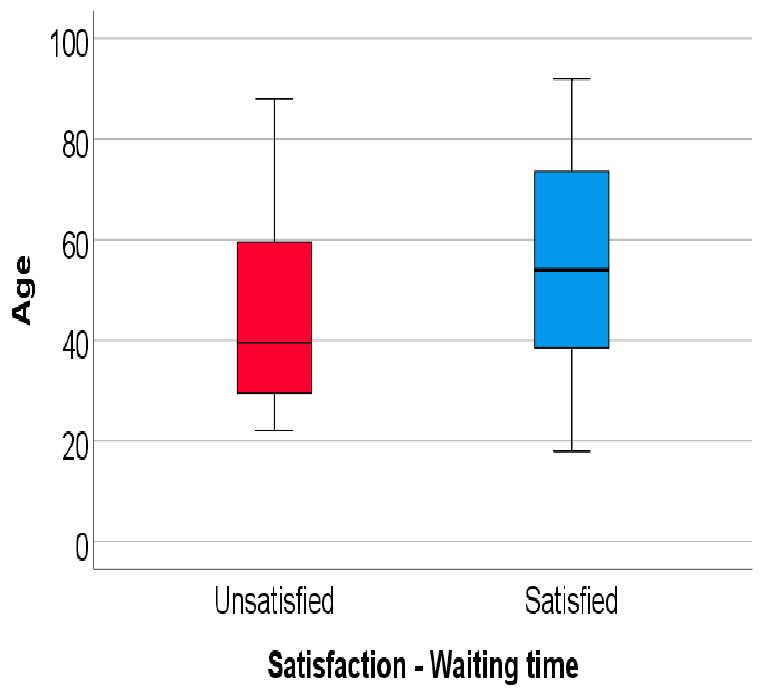
Figure 2. Comparison of age between answers according to satisfaction about the waiting time for coverage.